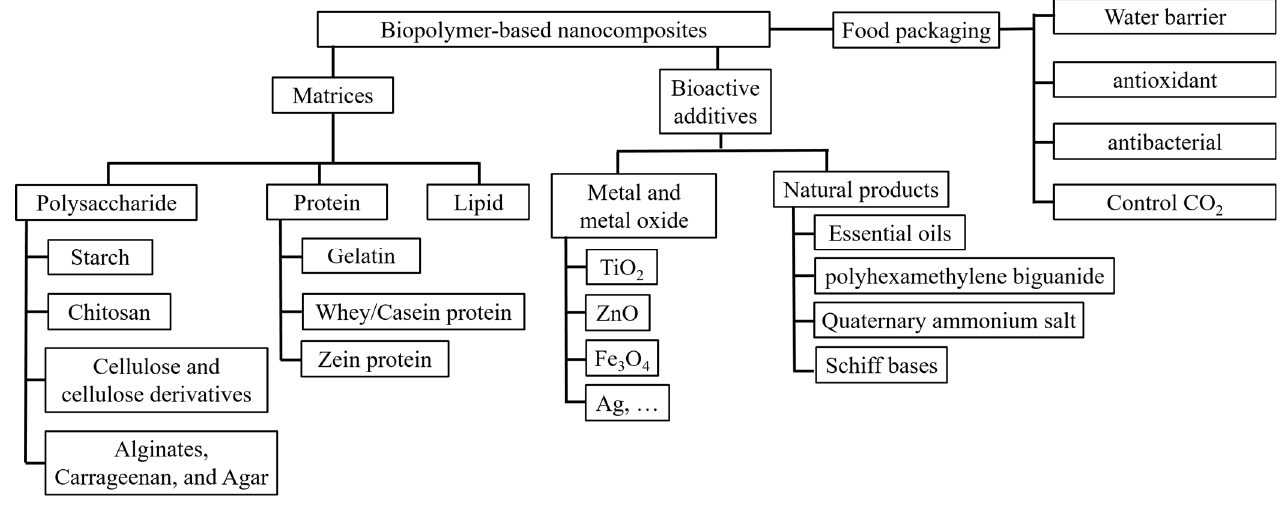
Figure 1. Components of biopolymer ‐ based nanocomposites and their properties for food packaging.